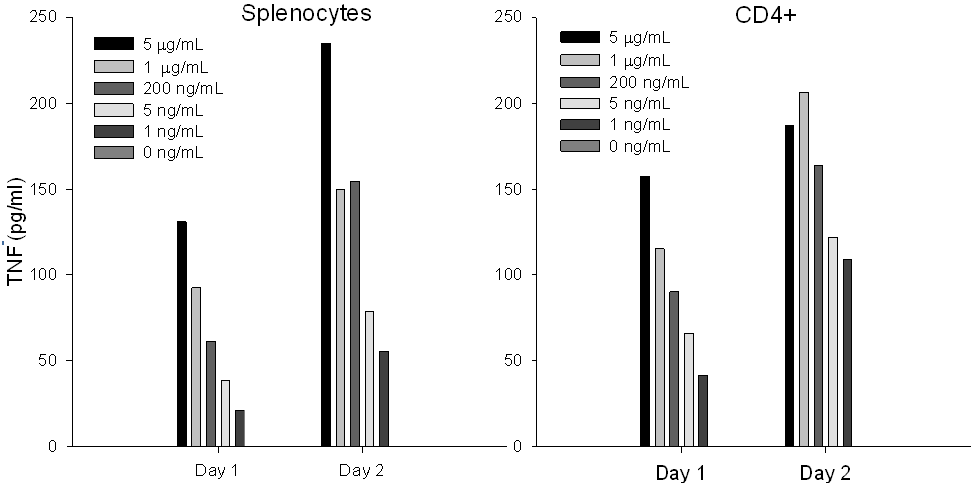
Figure 3. Flow cytometric analysis for quantification of biologically active SEA. Primary naïve CD4 + T-cells or splenocytes were spiked with increasing concentrations of SEA. After 24h or 48h of stimulation with SEA, TNF protein secretion was measured by flow cytometry.